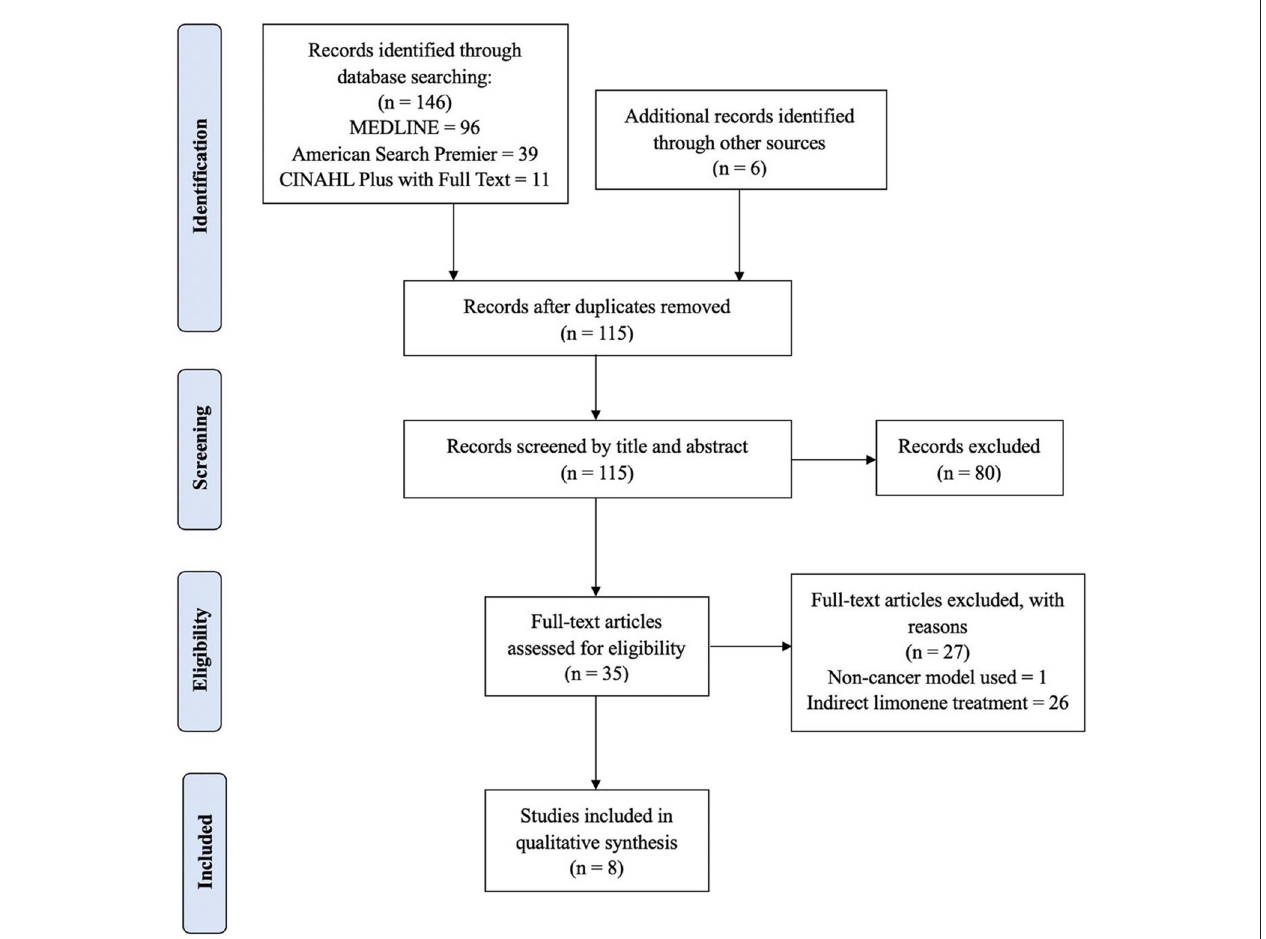
FIGURE 1 | Flow diagram of literature search and selection procedure for research included in the systematic review.